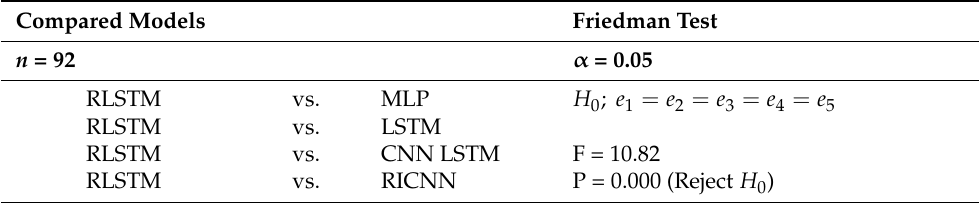
Table 10. Friedman test results for performance of next-day peak-electricity demand. Compared